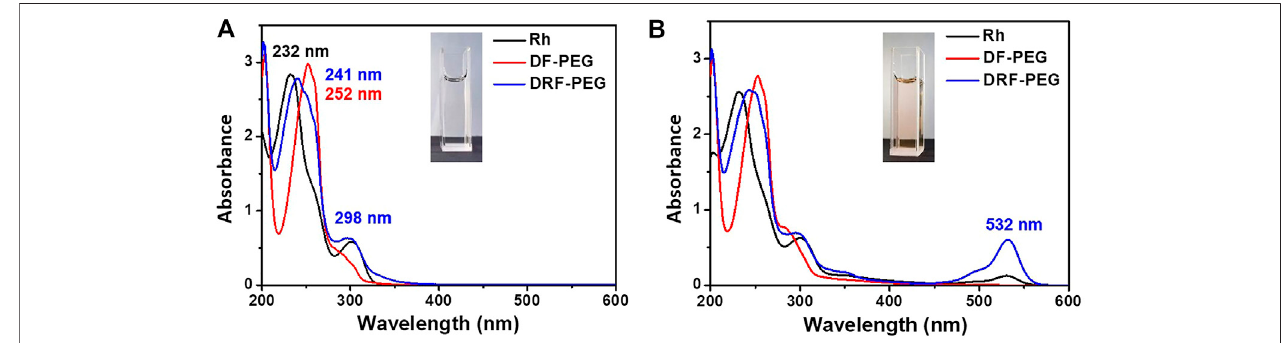
FIGURE 3 | Fluorescence (A) and UV-Vis (C) spectra of DRF-PEG (0.1 mg/ml) in the presence of various metal ions (10 – 4 M) in water (pH 6.5). Fluorescence emission intensity at 555 nm (B) and absorption intensity at 532 nm (D) of DRF-PEG (0.1 mg/ml) with various metal ions before and after the addition of Fe 3+ . The black bars are the absorption/ fl uorescent response of DRF-PEG to various metal ions (10 – 4 M). The red bars are the absorption/ fl uorescent response after the subsequent addition of Fe 3+ (10 – 4 M) to the above aqueous solution.